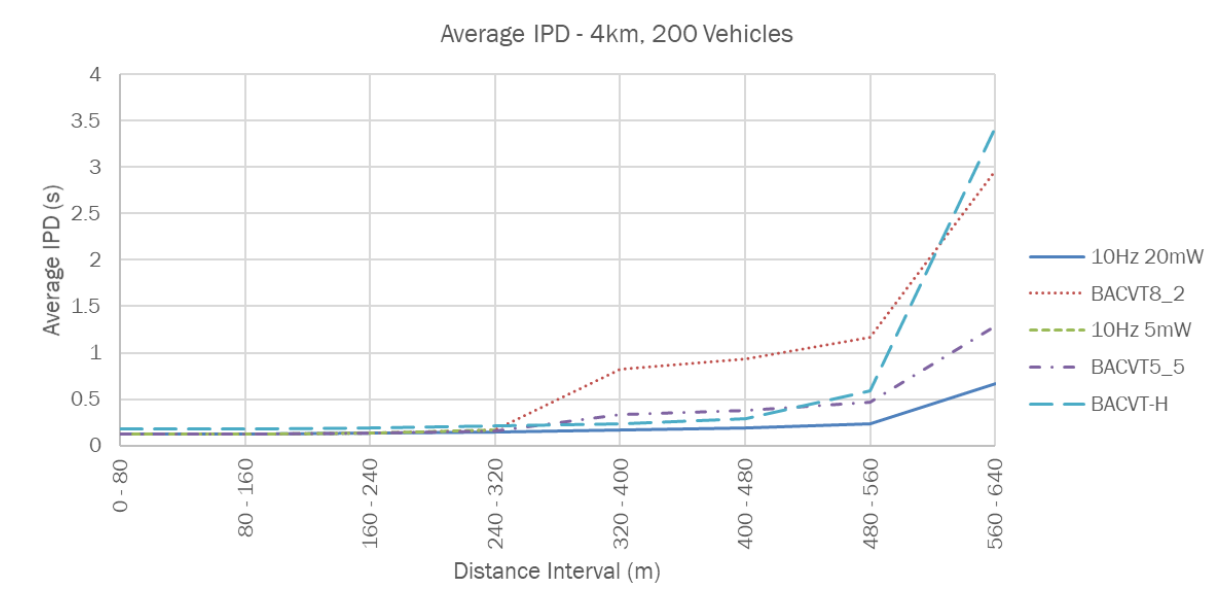
Figure 8. IPD in high vehicle density.